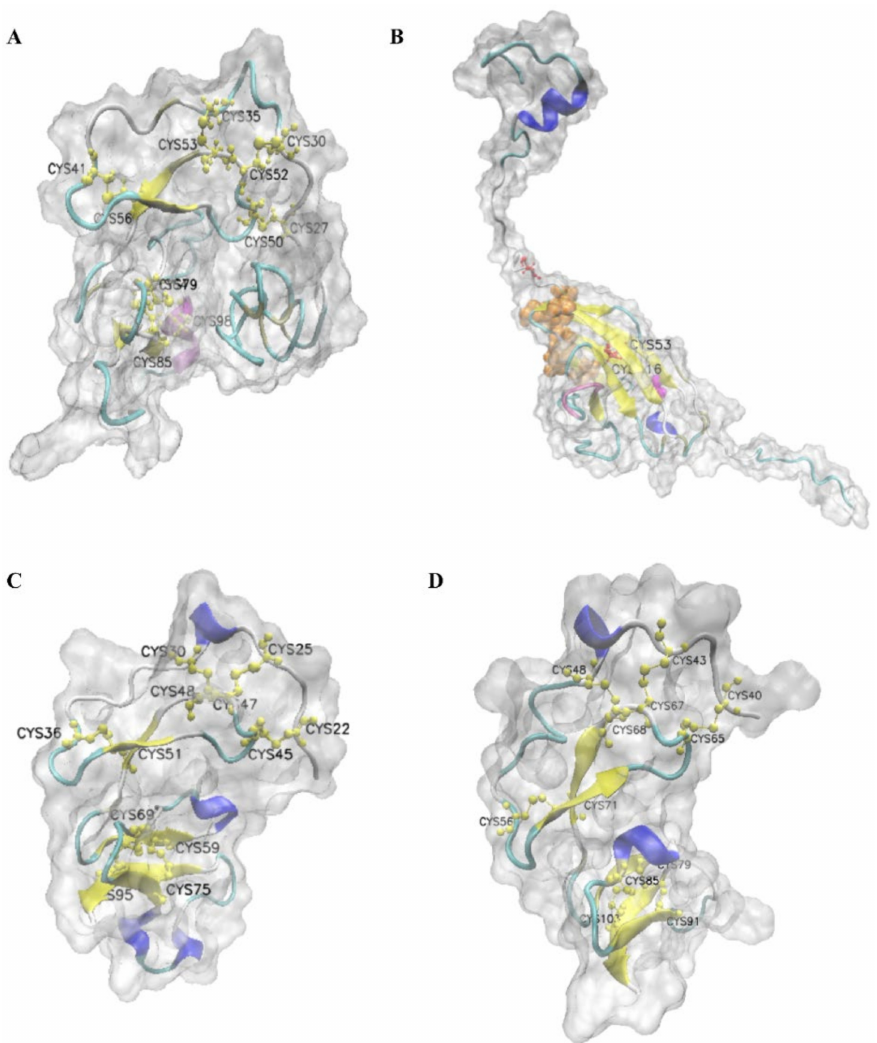
Figure 3. Predicted 3D structure of LvIGFBPs. ( A ) Predicted 3D structure of the N-terminal IB domain of LvIGFBP1. Cysteine residues are in green, and the CGCCxxC motif is in mauve; ( B ) predicted 3D structure of the C-terminal IGc2 domain of LvIGFBP1; ( C ) predicted 3D structure of LvIGFBP2; and ( D ) predicted 3D structure of LvIGFBP3. Cysteine residues are in yellow, predicted ligand binding sites are in orange, predicted enzyme active sites are in magenta, and the RGGP motif is in mauve. The β -sheet is in yellow, the helix is in blue, the β -turn is in cyan, and the random-coil is in